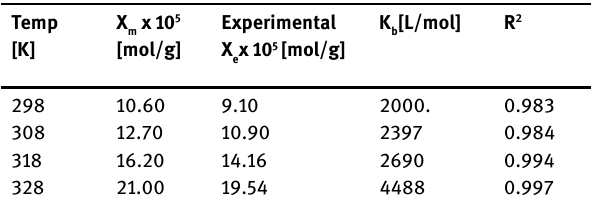
Table 2: Langmuir parameters for Cr (VI) adsorption on nano-powder